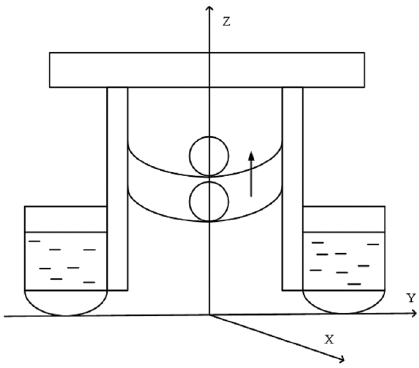
Figure 3. Robot rescue method.